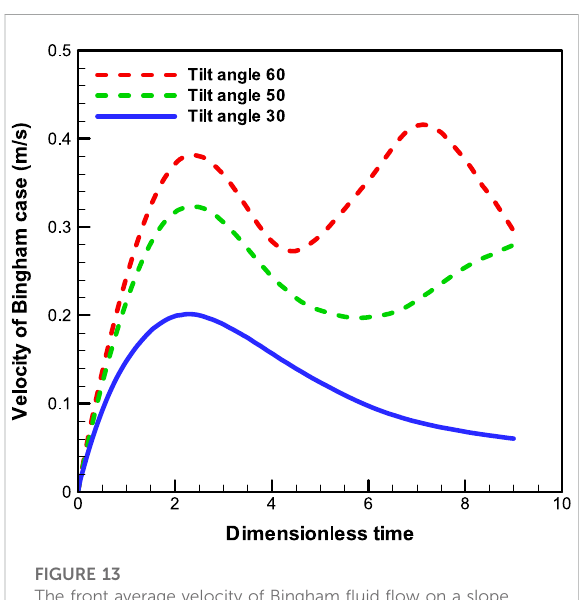
FIGURE 13 The front average velocity of Bingham fl uid fl ow on a slope with the tilt angles of 30 ° , 50 ° , and 60 °